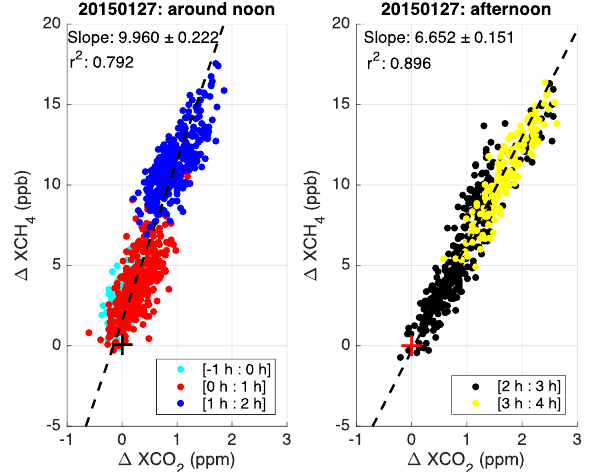
Figure 5. First and second panels: measured X CO and X CH north 2 4 Figure 7. Column difference ratios measured across Pasadena col- (ha) and south (hb) of Pasadena on 27 January with 5min averaging ored by hours. Left figure shows the time period between 1h before time. Third panel: (cid:49)X CO and (cid:49)X CH are temporally correlated 2 4 solar noon and 2h after solar noon, and right figure shows the time and their ratio is determined as 7.8ppbppm − 1 , shown in Fig. 6. period 2 to 4h after solar soon. The solar noon is about 12:05 lo- cal time. Both regression curves essentially pass through the origins that are shown as